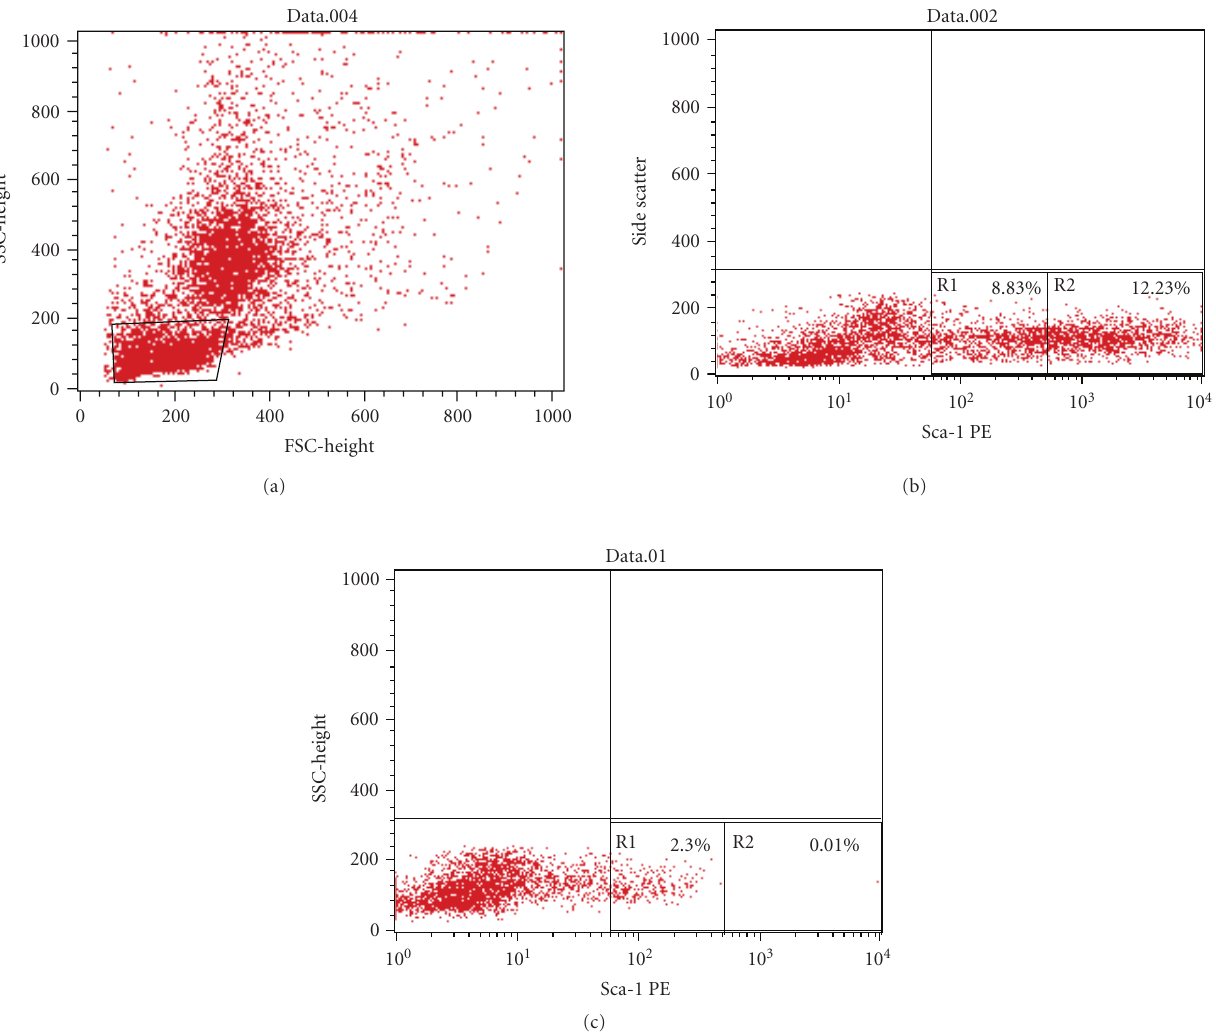
Figure 1: (a) Gated region of flowcytometric analysis. (b) Phenotypic characterization of Sca-1 expression by normal bone marrow cells. R-1 region indicates the Sca-1 dim population (8.83%). R-2 region indicates the Sca-1 bright population (12.23%). (c) Phenotypic characterization of Sca-1 expression by Aplastic anemic bone marrow cells. R-2 region, that is, Sca-1 bright population is more severely a ff ected (0.01%) compared to the Sca-1 dim population in the R-1